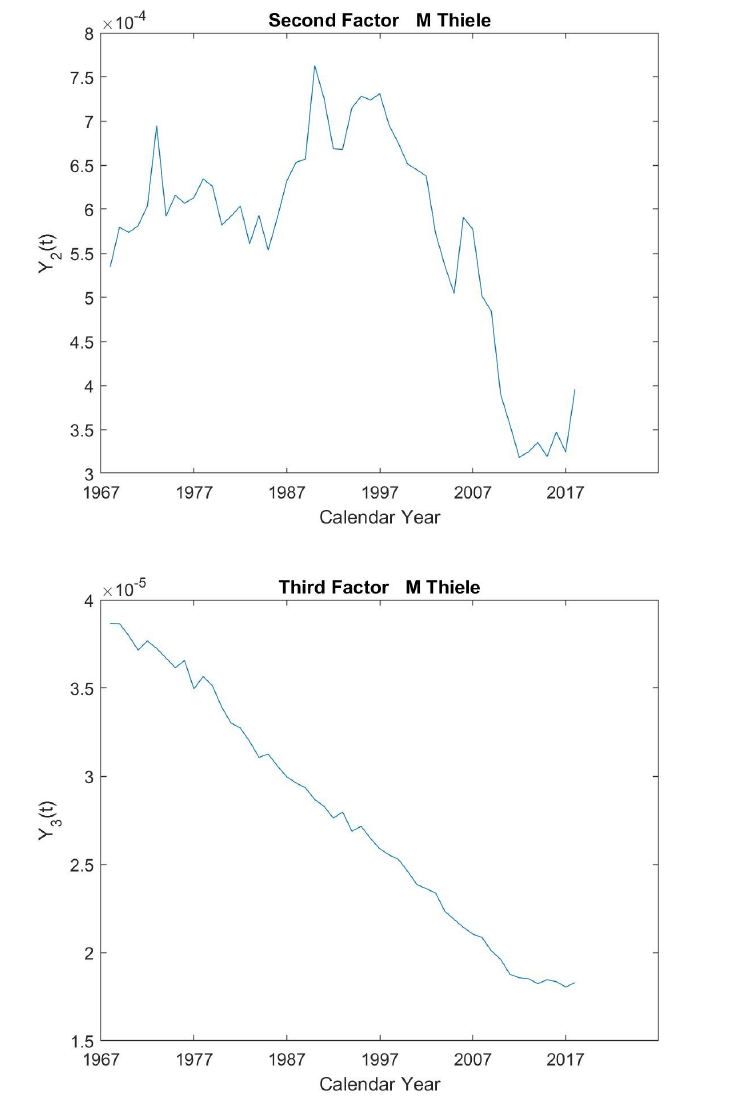
Figure 3. The figure plots the values of the three factors, Y 1 , Y 2 , Y 3 . In our estimation procedure, we have not constrained the value of the parameter that controls the age which is mostly affected by the second factor. Thus, the factor affects the different populations differently. For example, it influences female mortality at young adult = 23.1866). For males, it instead adds up to ages to help to address the accident hump ( γ f 4 = 88.2853). As Figure 4 shows, the third factor in influencing mortality at older ages ( γ m 4 the model’s fit is very good for both female and male populations, with an average MARE across all observations of 11.47%. The first factor helps capture the infant mortality spike at age 0. Mortality at young adult ages and at older ages is slightly more difficult to capture for males, for which MARE is above the average between ages 18 and 23. Between ages 40 and 70, the curve’s fit is better for males than